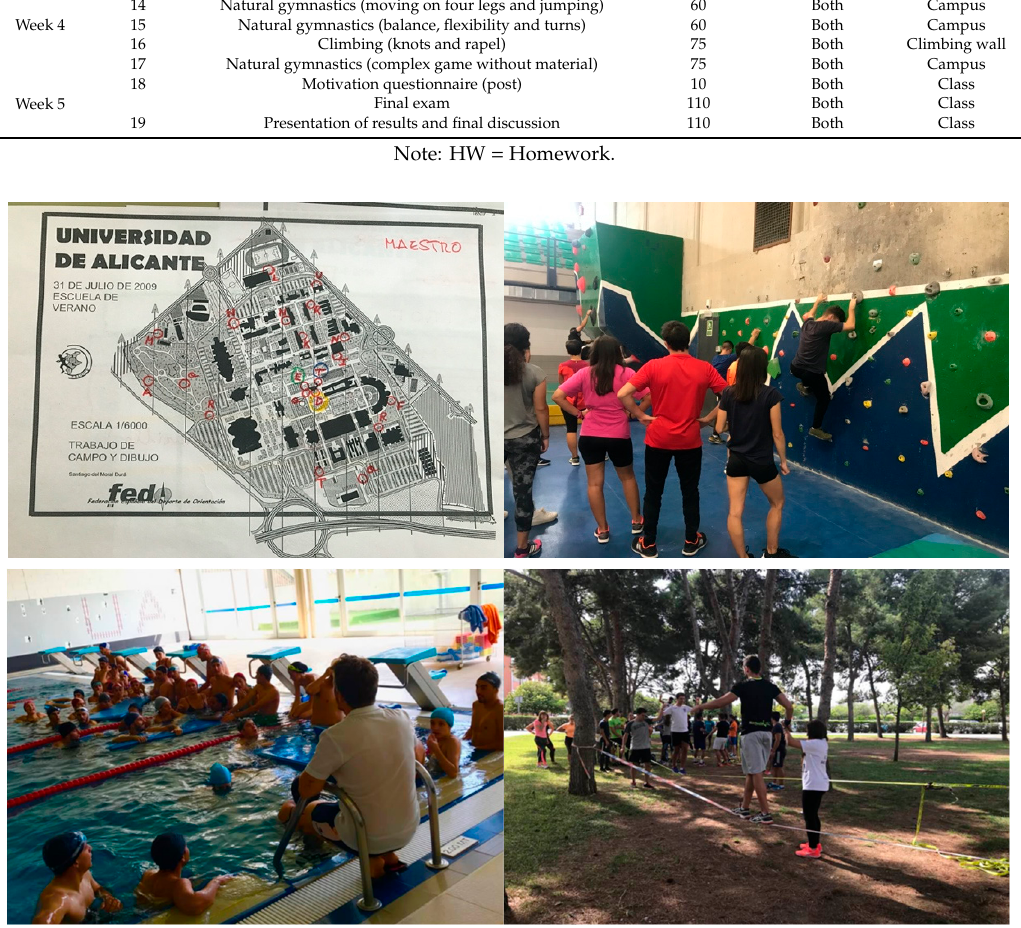
Table 3. Equivalences between behaviours and gamified points .